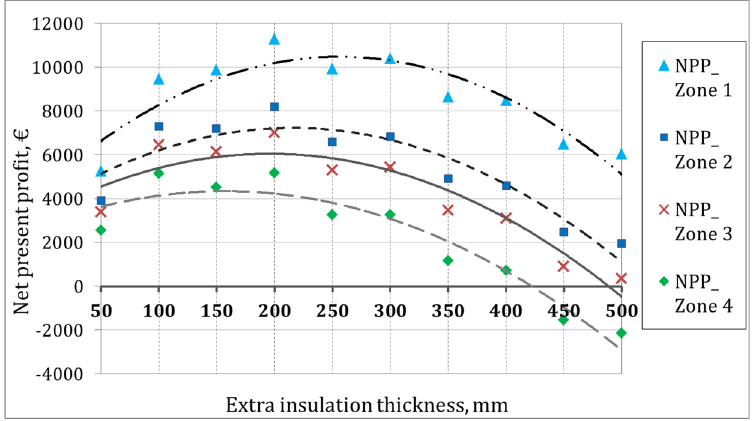
Figure 11. Net present profit of additional insulation on the attic floor for the base case scenario.